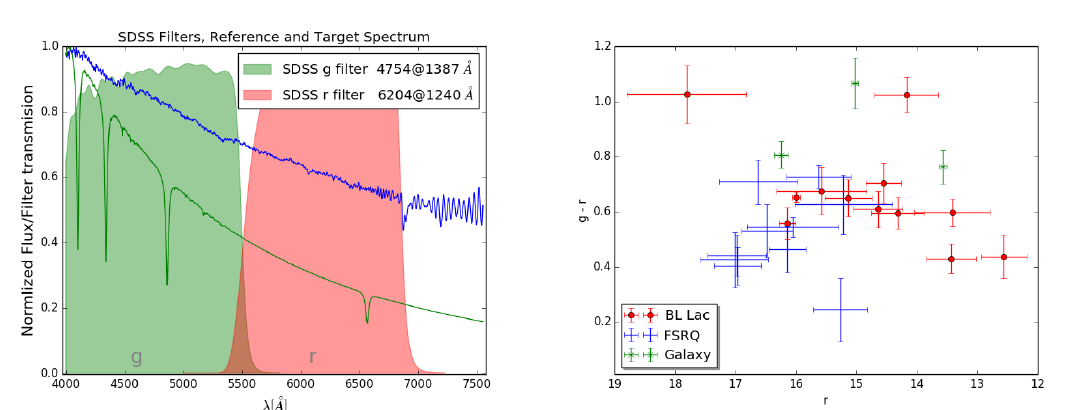
Figure 4. Left panel: A sample spectrum to show the spectral range, overlaid with the transmission curves of the Sloan filters g’ and r’ . Right panel: Average colour g-r of the objects in our